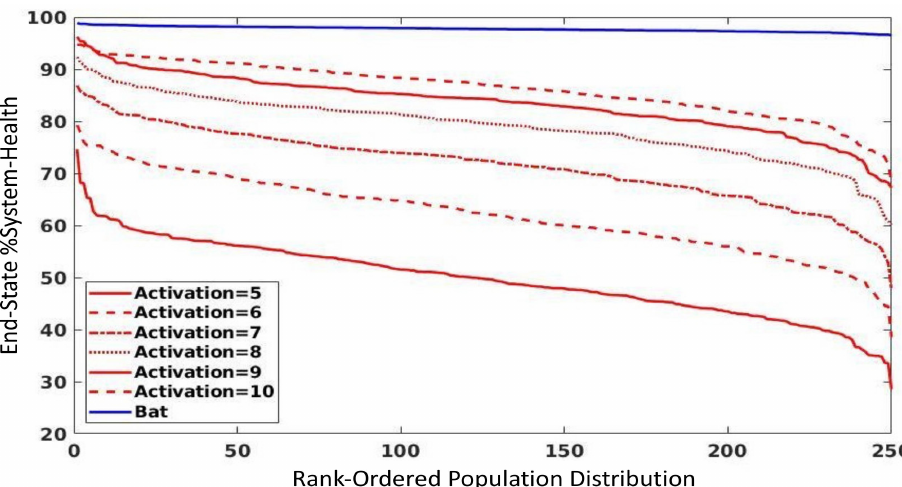
Figure 4. Parameter sweep of endothelial activation threshold level from baseline human param- eterization (= 5) to baseline bat parameterization level (= 10) with initial inoculum = 150, 14 days of simulated time. The endothelial activation threshold reflects the ability to activate the endothe- lial inflammasome, with subsequent effects (adhesion activation and PAF production) that recruit circulating PMNs to the area of activation. There is a progressive reduction in the degree of tissue damage/disease severity across simulated populations (stochastic replicates n = 250) with increasing endothelium activation thresholds (simulating decreasing endothelial inflammasome activation), though even when the endothelium activation threshold is at the same level (= 10) between the bat- and human parameterizations, there is still an increased tolerance of the bat versions to viral